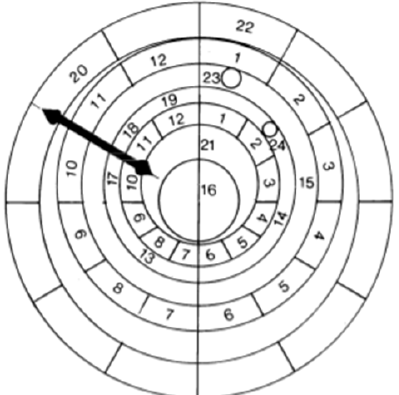
Figure 14. Castle water clock built by Al-Jazari. It included a dis- play of the solar and lunar orbits and the phases of the Moon (Hill,